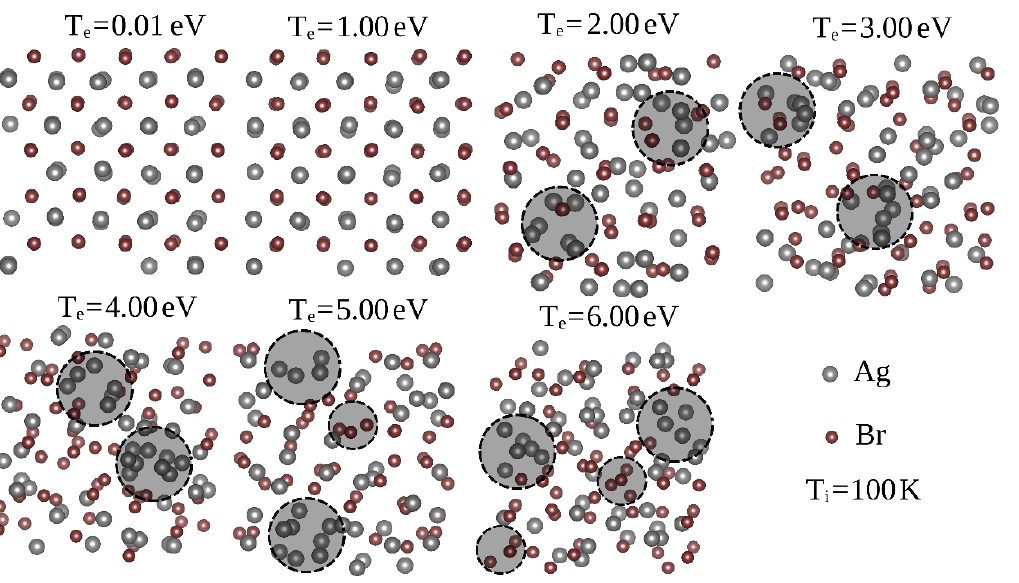
Figure 4. Two-temperature model calculations to simulate the FLI. The Ag and Br atoms are depicted in silver and brown colors, while their clusters are represented by gray circles.